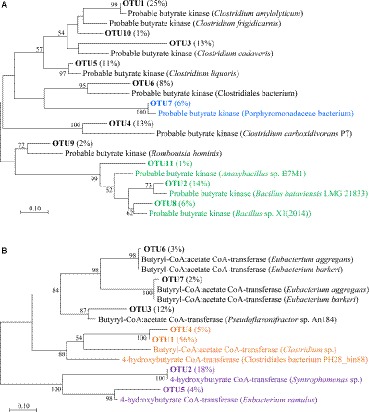
Phylogenetic diversities of buk and but genes in the fermented grains of Luzhou-flavor baijiu. (A) A neighbor-joining tree of deduced protein sequences of buk genes. Green, blue and black branches indicate Bacilli, Bacteroidia and Clostridia, respectively. (B) A neighbor-joining tree of deduced protein sequences of but genes. Black, orange and purple branches indicate real but, candidate but and 4-hydroxybutyrate CoA-transferase gene, respectively. For (A) and (B), bootstrap values from 1,000 replicates are included. Percentage in the bracket shows the relative abundance of specific OTU.